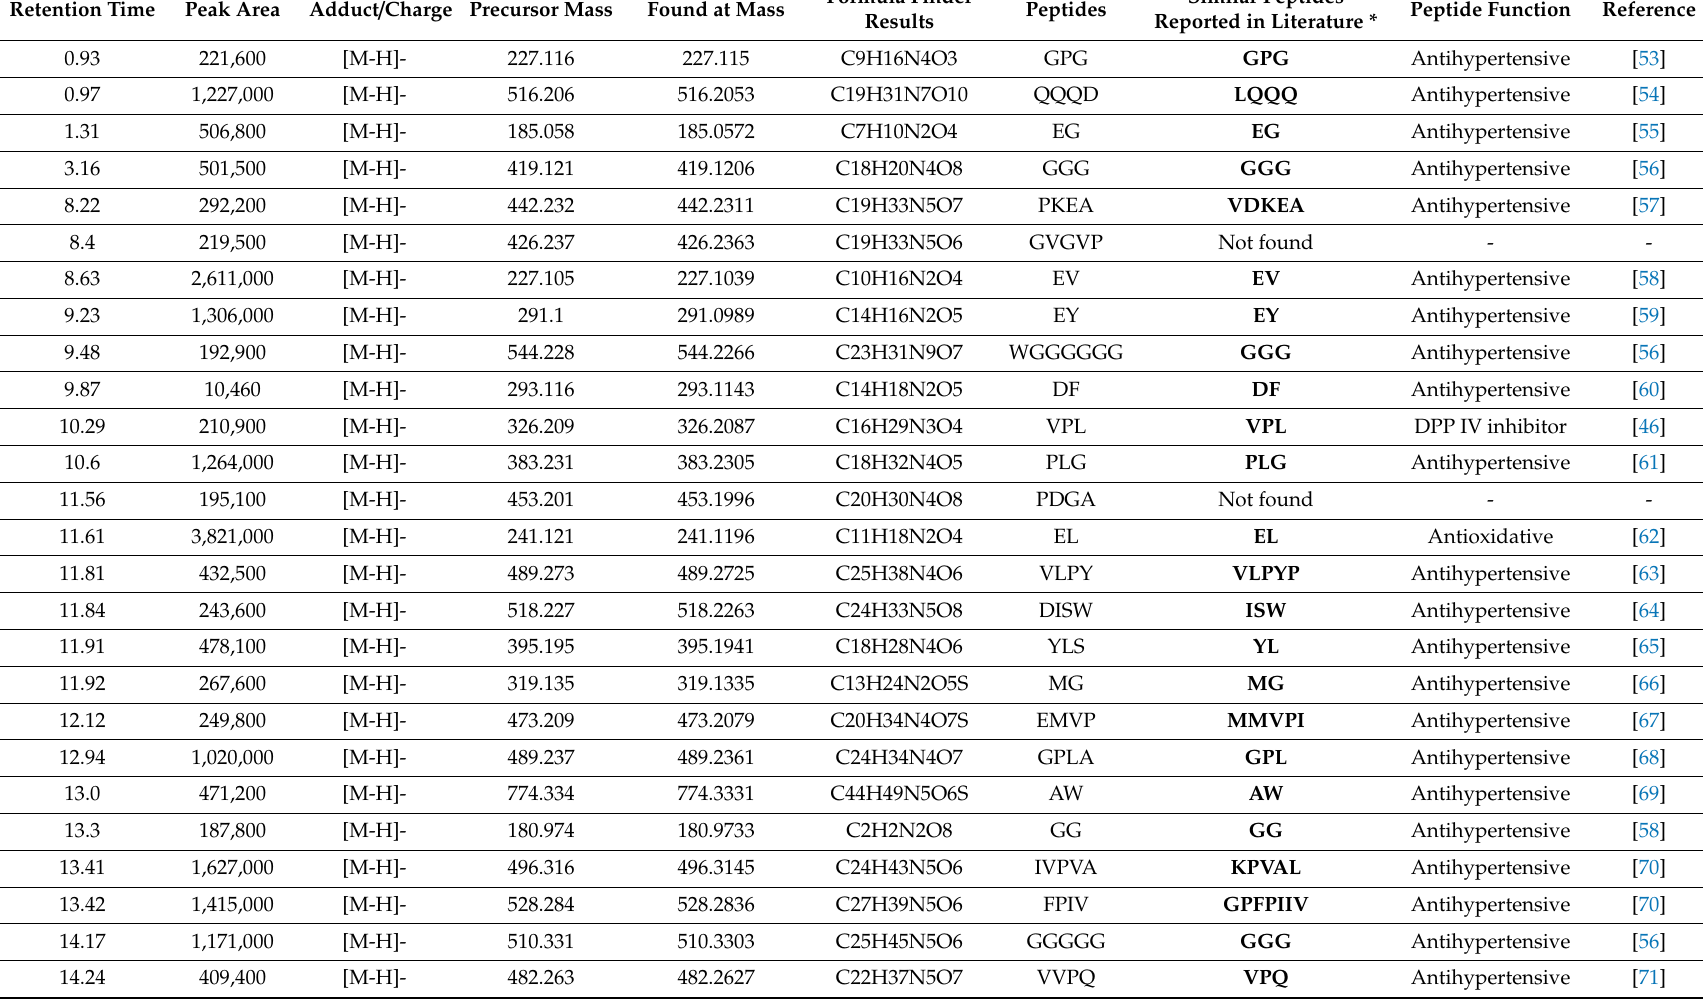
Table 1. Peptides identified in Enterococcus faecium EBD1 fermented